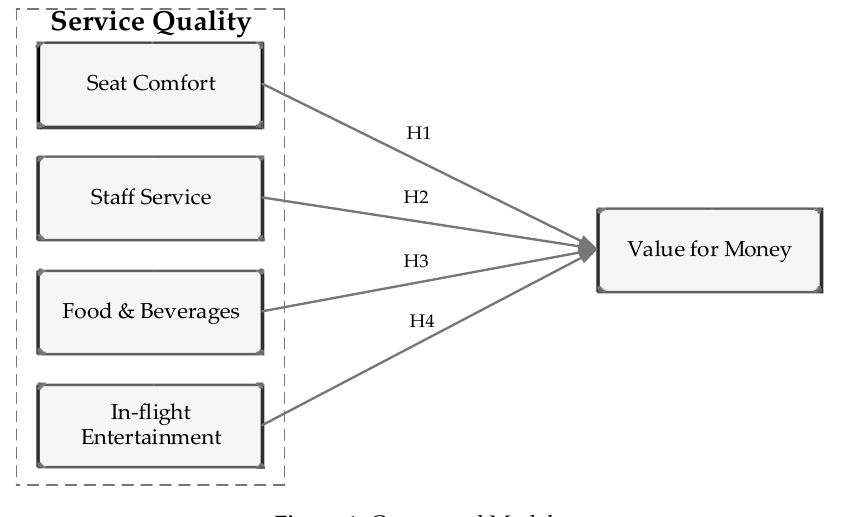
Figure 1. Conceptual Model.